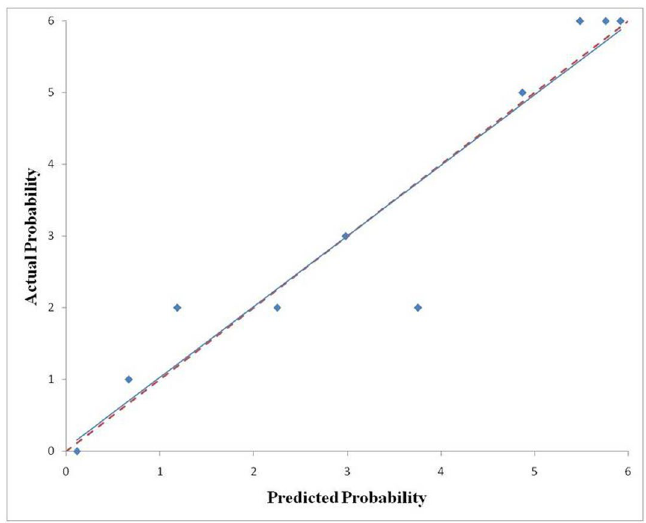
Figure 6. Calibration curves of the nomogram for predicting invasive pulmonary adenocarcinoma lesions from the validation cohort. The Hosmer–Lemeshow test had a p value of 0.917 in the validation